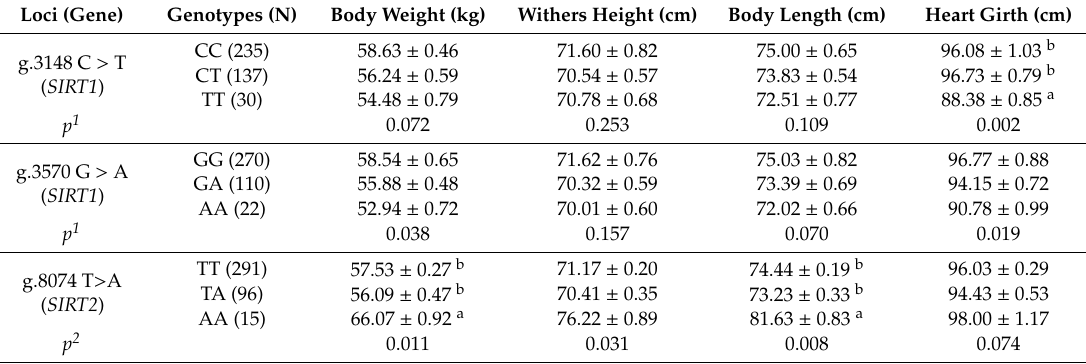
Table 4. Association of genotypes of SNPs in SIRT1 and SIRT2 with growth traits in Tibetan